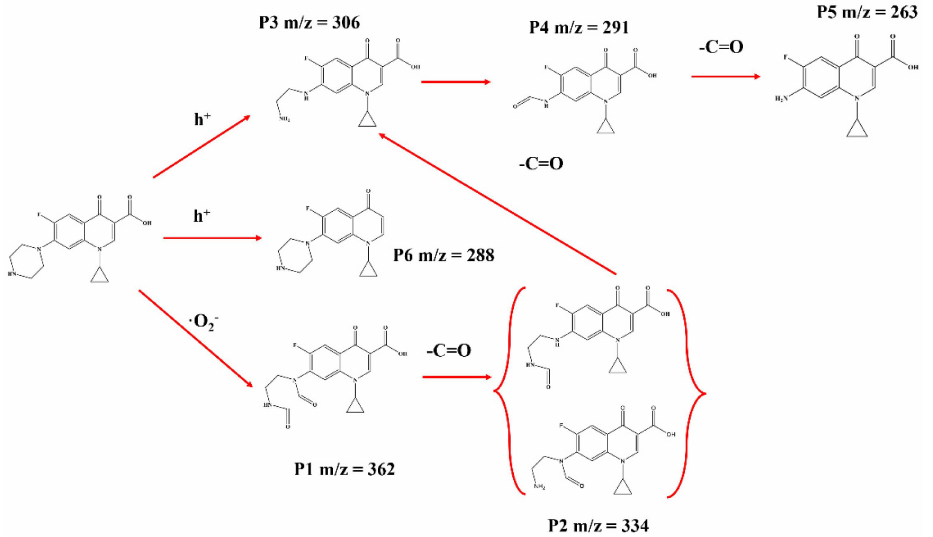
Figure 10. Possible degradation pathways of CIP on